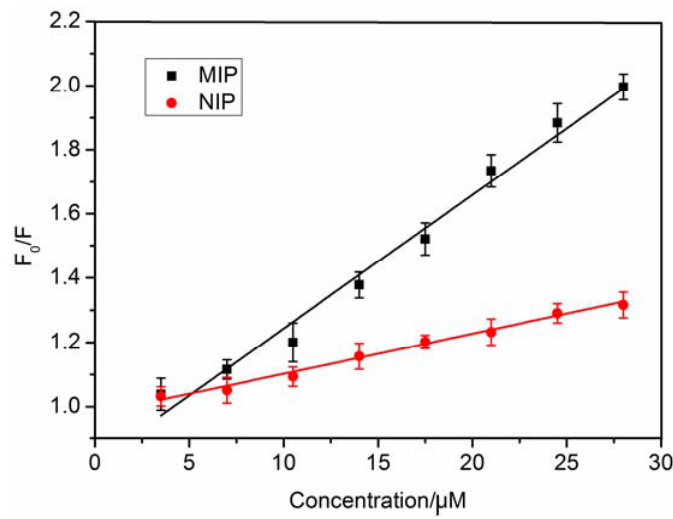
Figure 4. Stern-plot of MIP and NIP.